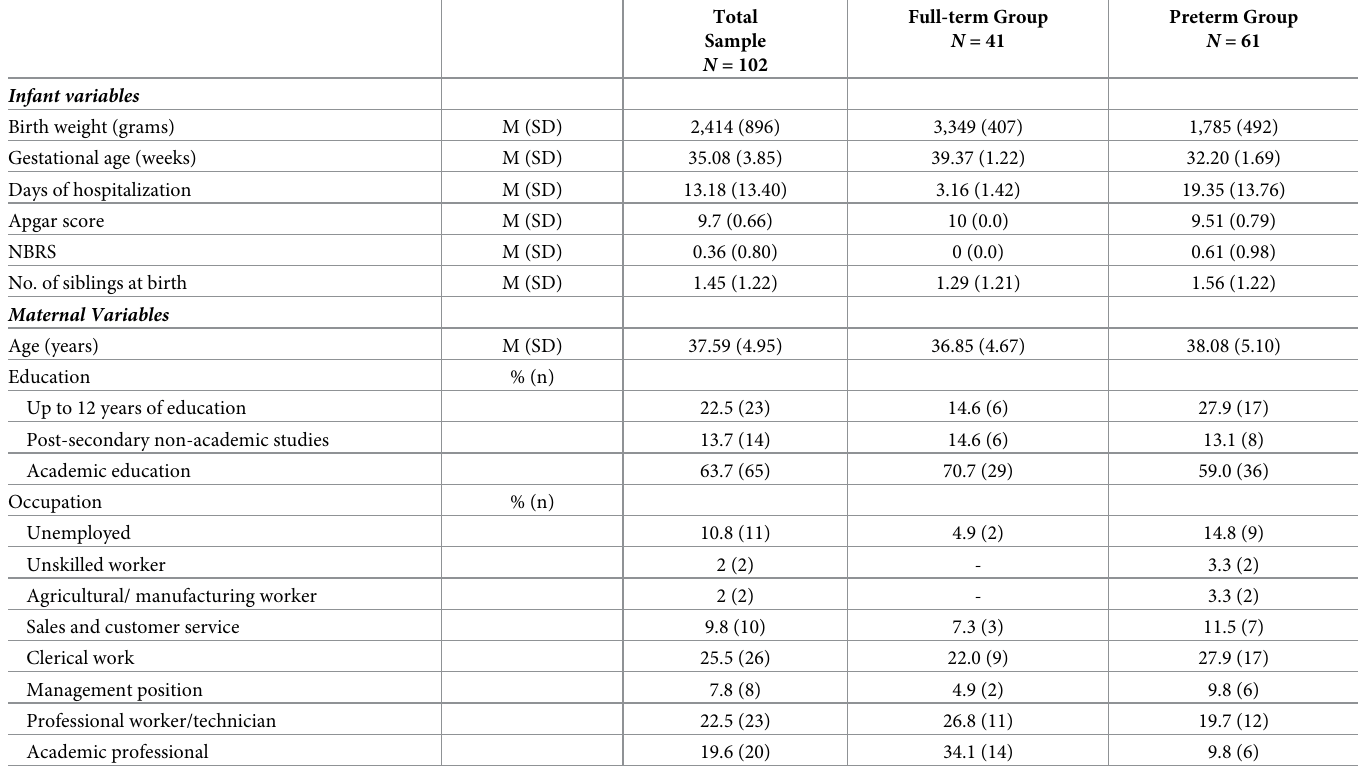
Table 1. Demographic information for the total sample and by prematurity group.